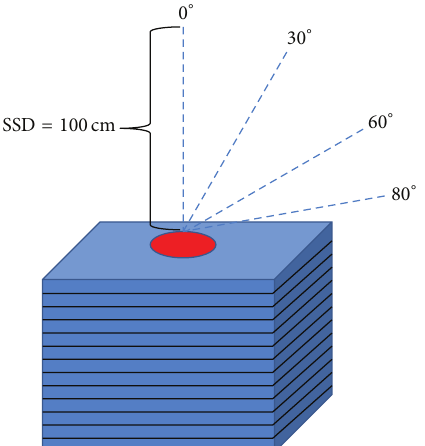
Figure 1: Schematic of oblique beam irradiation with gantry